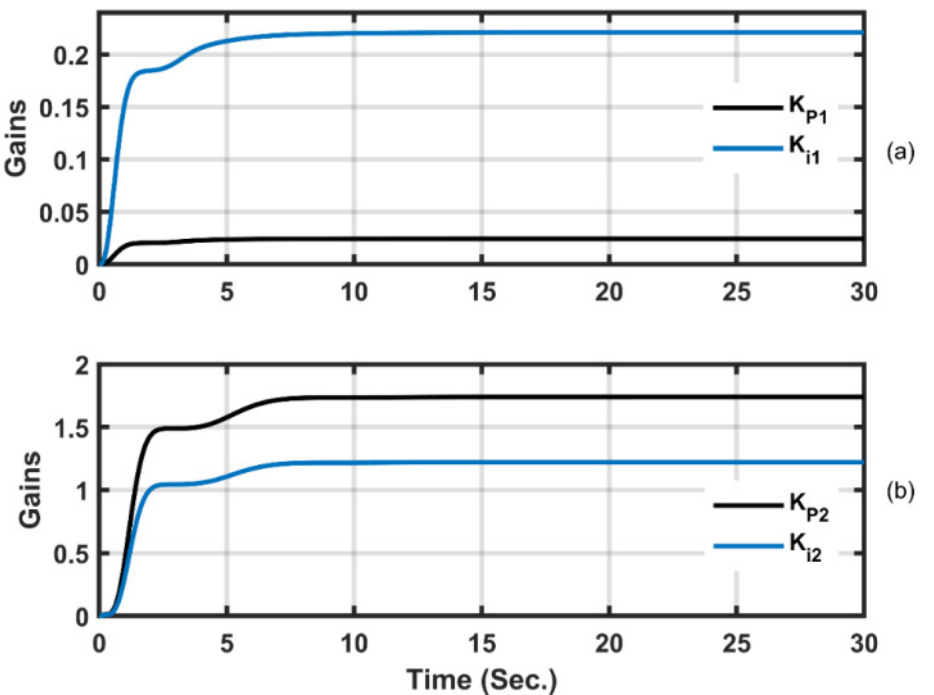
Figure 17. Proportional and integral gains of proposed adaptive controller: ( a ) area 1 and ( b ) area 2 under disturbance in thermal demand.